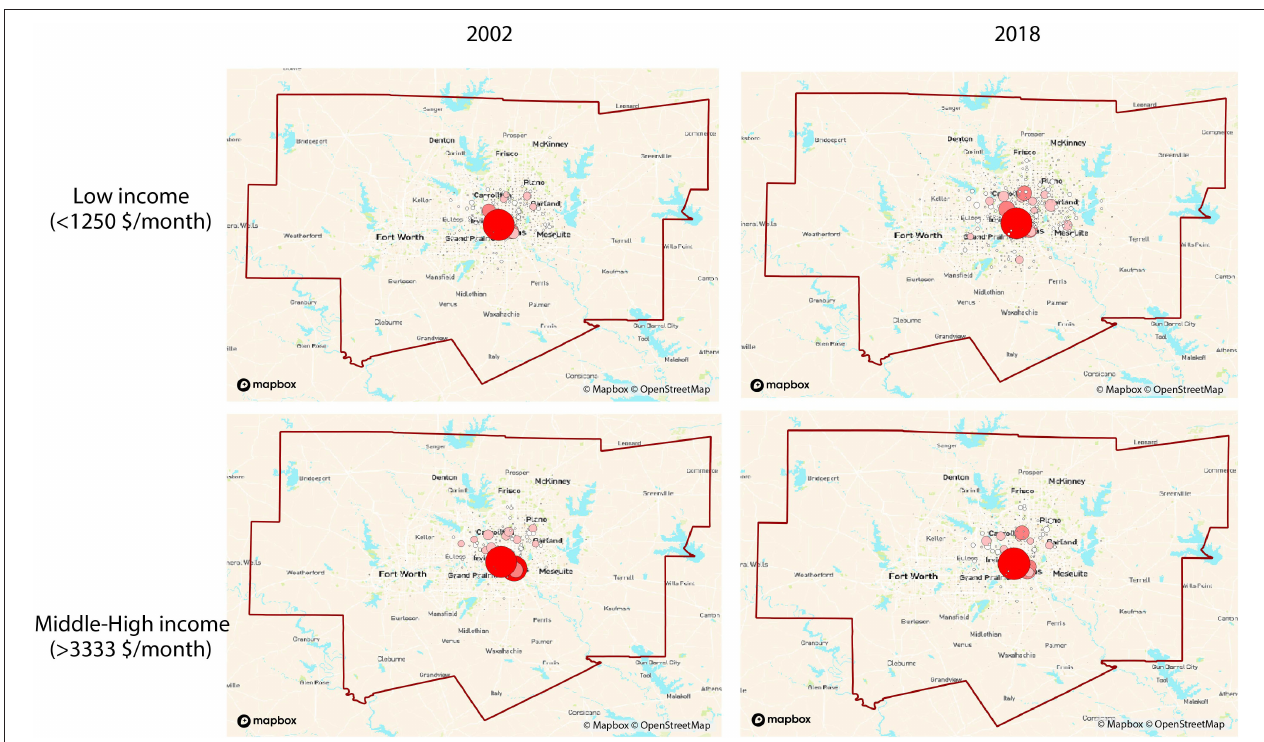
FIGURE 3 | Flow networks of home places of workers commuting to workplaces located in the city centers (around the red circle) based on income groups (weighted out-degree). Node size and color [light (low)-dark (high)] indicates the degree ranking in